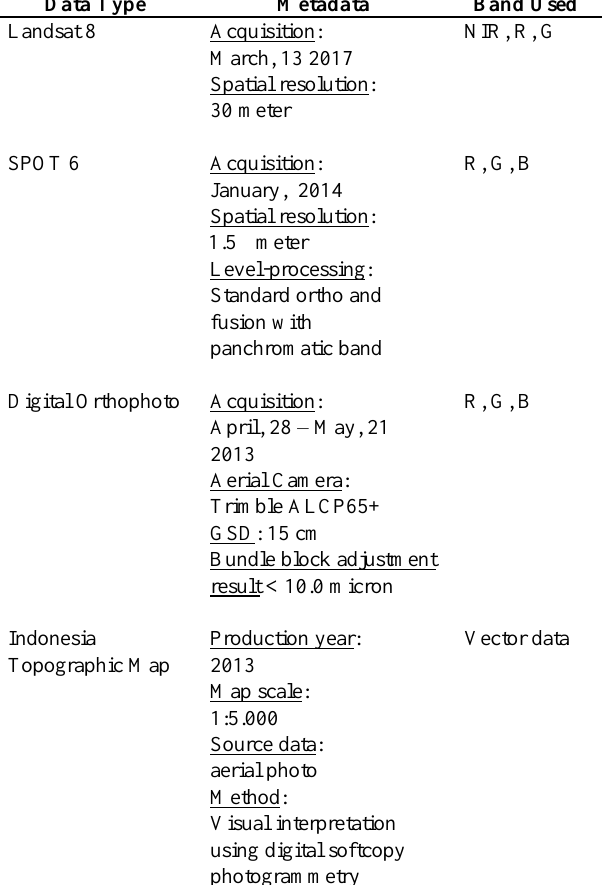
Table 1. Data source information: Data Type